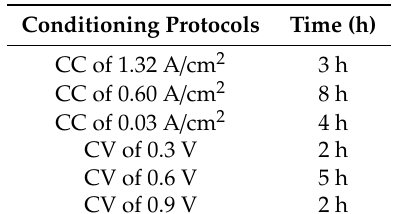
Figure 6. Principle of difference between ( a ) CV and ( b ) CC modes in the conditioning process. Table 2. Time required for complete conditioning. Time (h)